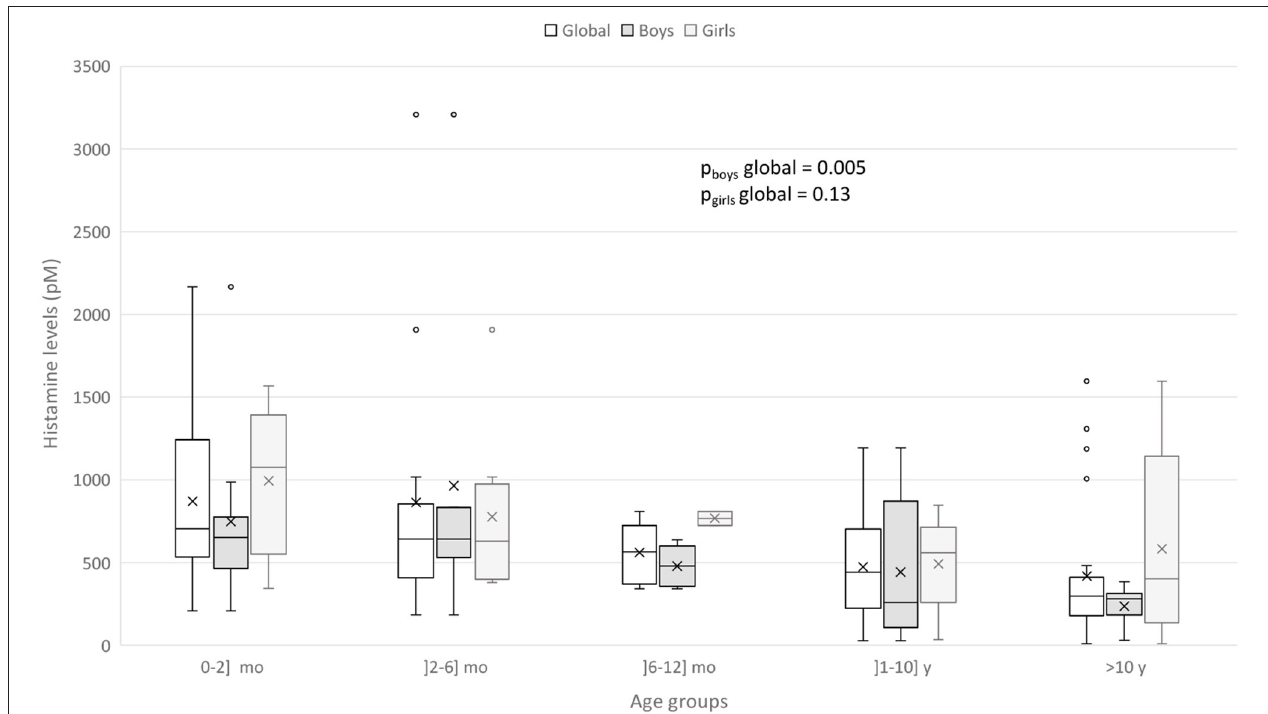
FIGURE 2 | Box-and-whisker plot for CSF HA according to sex and age groups. The minimum value, 25 th percentile, median, 75 th percentile, and the maximum value are represented. The cross is the mean value.